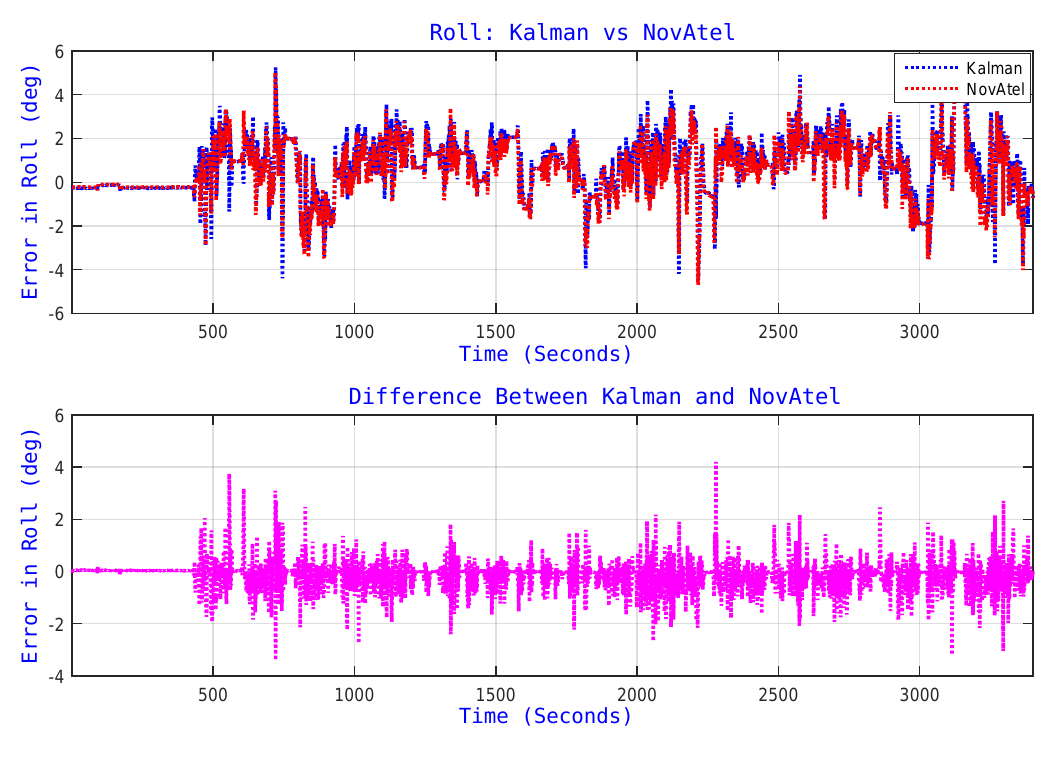
Figure 12. (Top) Performance of estimated roll angle versus the reference (NovAtel) for the Kingston trajectory. The bottom plot shows the difference between the two